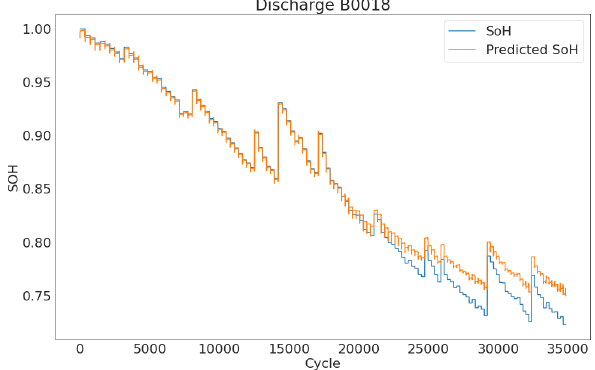
Figure 11. SoH prediction for battery fault detection